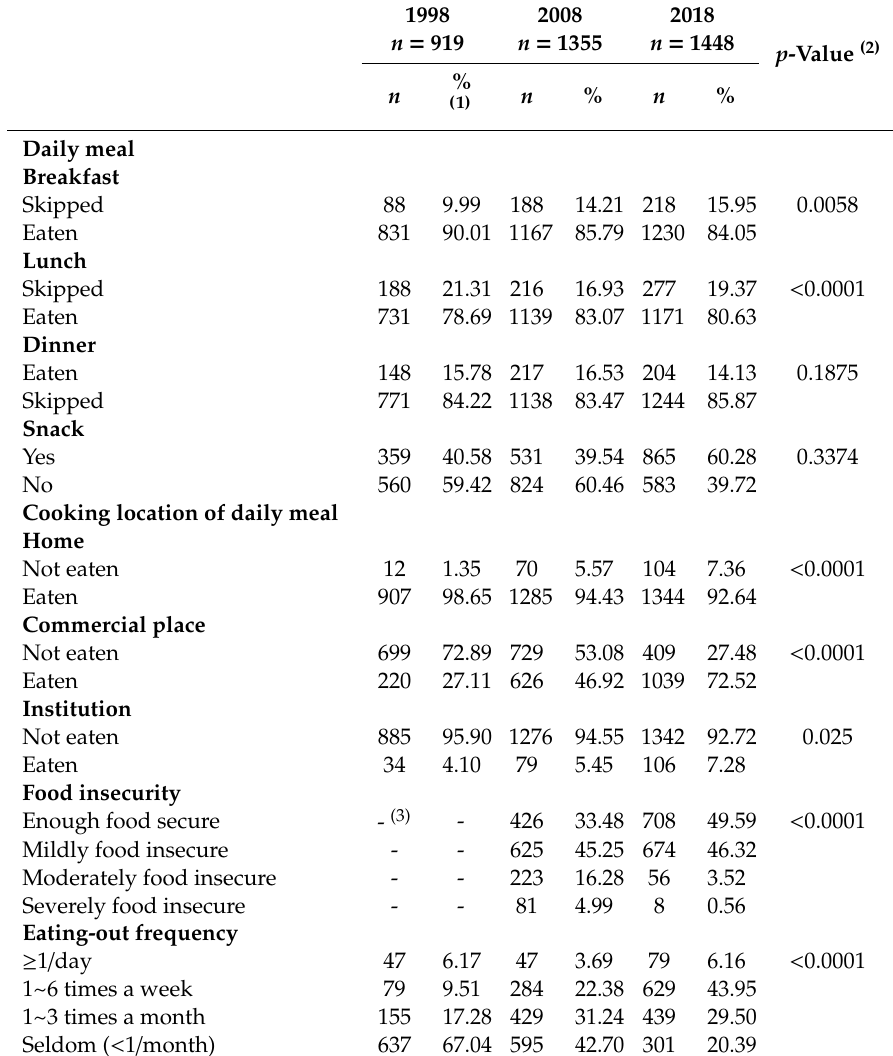
Table 4. Dietary behavior of subject sample by survey